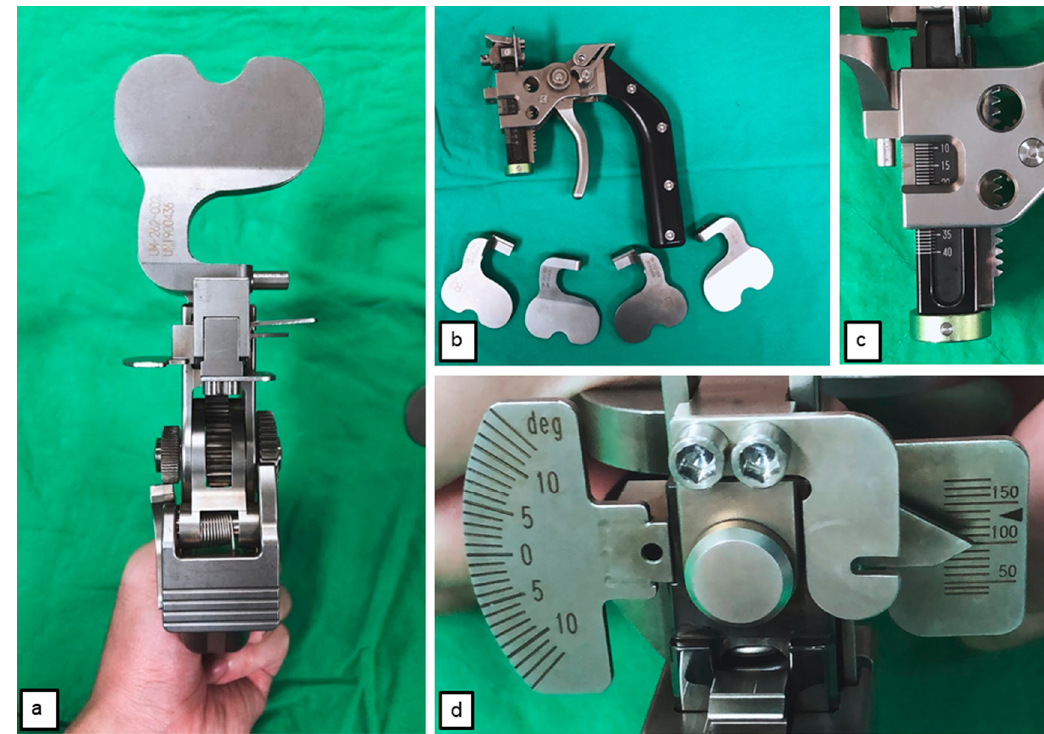
Figure 1. The tensioner: ( a ) top view; ( b ) side view; ( c ) ruler at the side; ( d ) 100 Nm force set to distract the knee joint.